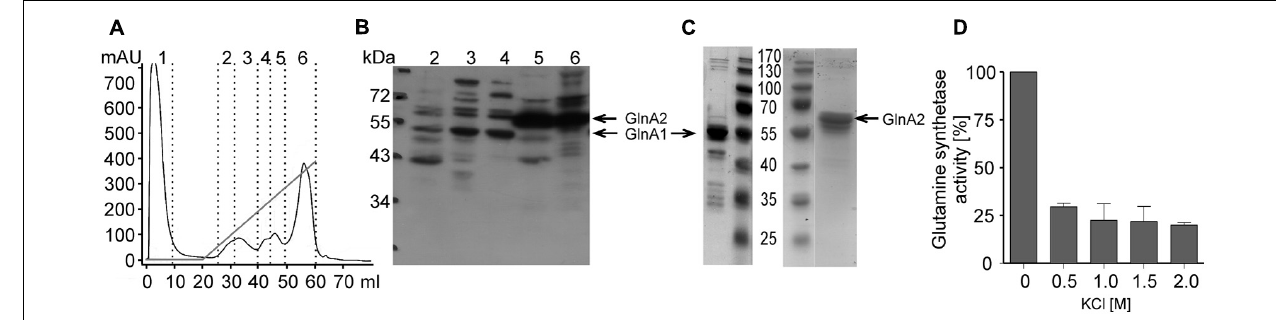
while GlnA2 eluted in fractions 5 and 6 as shown by Western blotting (B) . Subsequently, GlnA1 and GlnA2 were enriched to higher purity by gelfiltrations of fraction 2–4 and 5–6, respectively (C) . Glutamine synthetase activities were measured for purified GlnA1 at different KCl concentrations in the assay (D) . GlnA2 has not shown any activity at the conditions